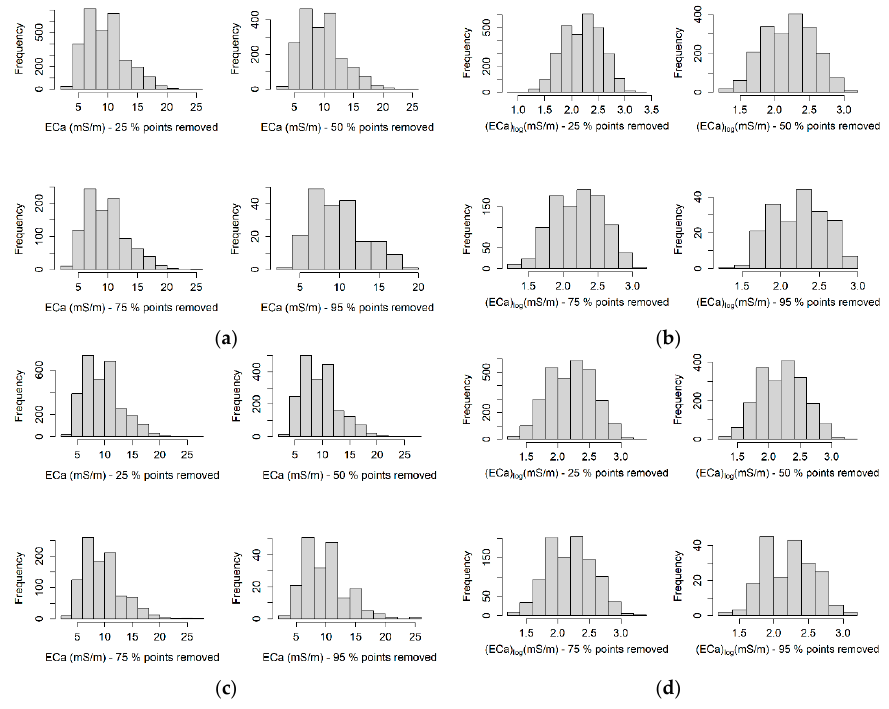
Figure 7. Histograms for soil ECa datasets from di ff erent sample density reductions (i.e., 25%, 50%, 75%, and 95%), considering: the random selection algorithm with actual values ( a ) and natural logarithm transformation ( b ); and the Douglas-Peucker algorithm with actual values ( c ) and natural logarithm transformation ( d